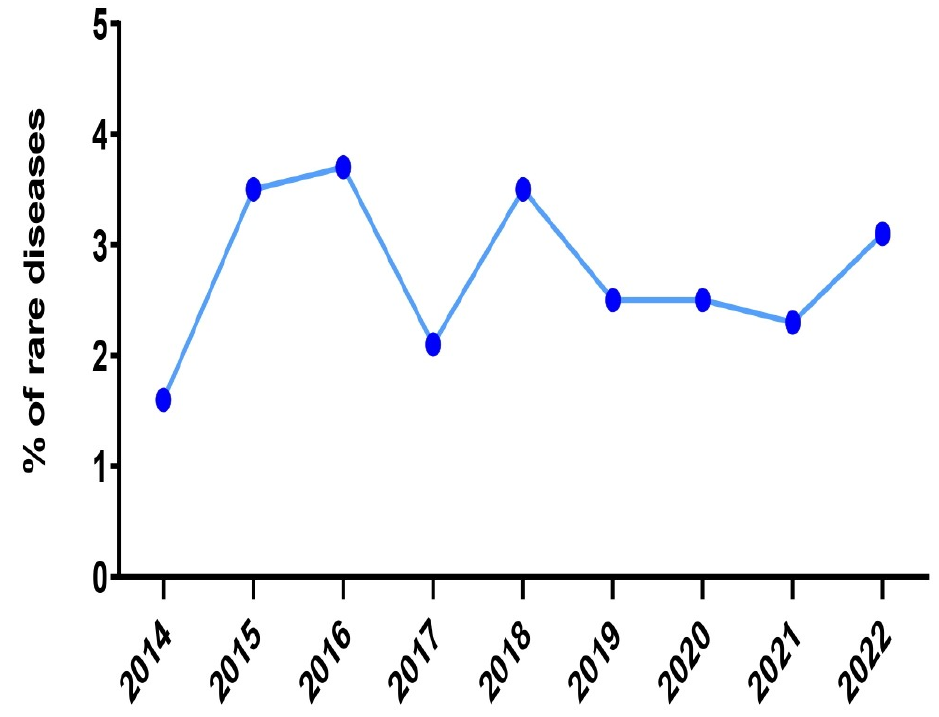
Figure 4. The incidence of rare diseases in the 2nd Department of Neurology, AHEPA University Hospital of Thessaloniki over the years 2014, 2015, 2016, 2017, 2018, 2019, 2020, 2021 and the first trimester of 2022.